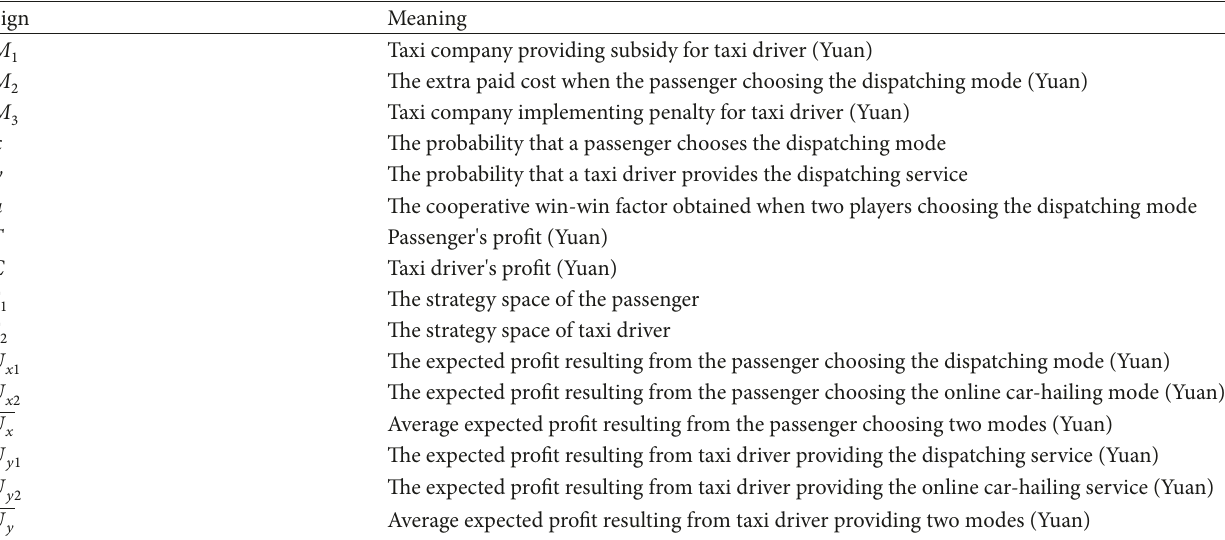
Table 1: The names and meanings of